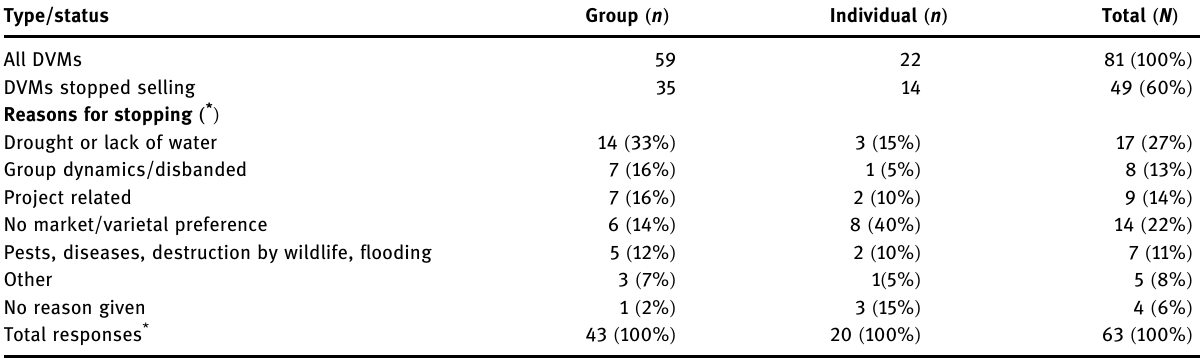
Table 3: Reasons for stopping selling sweetpotato vines for groups and individuals, Lake Zone, Tanzania, 2016 – 2017